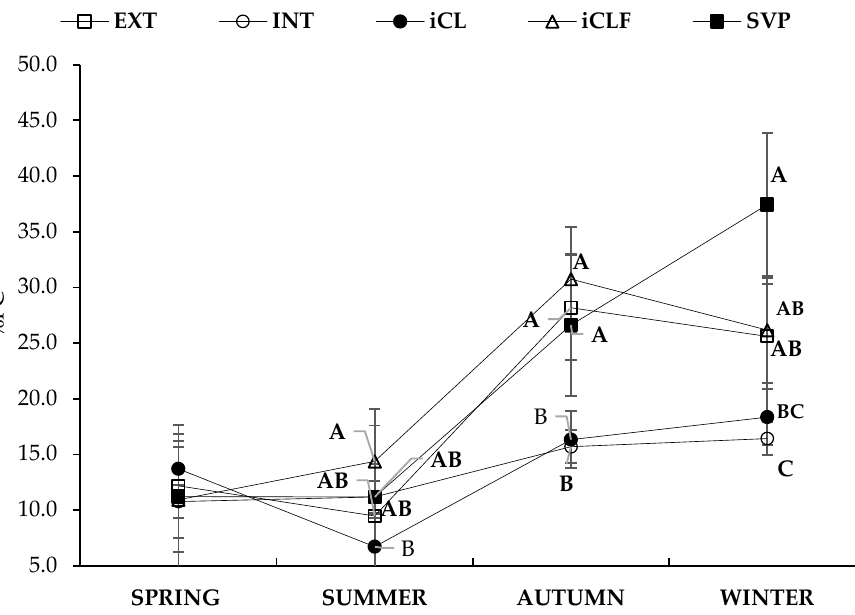
Figure A7. Feed conversion (in %) during seasons from different livestock production systems (means of two years). Different letters in the same season differ from each other ( p < 0.05) according to the Tukey test. EXT: extensive; INT: intensive; iCL: integrated crop–livestock; iCLF: integrated crop–livestock–forest; iLF: integrated livestock–forest.